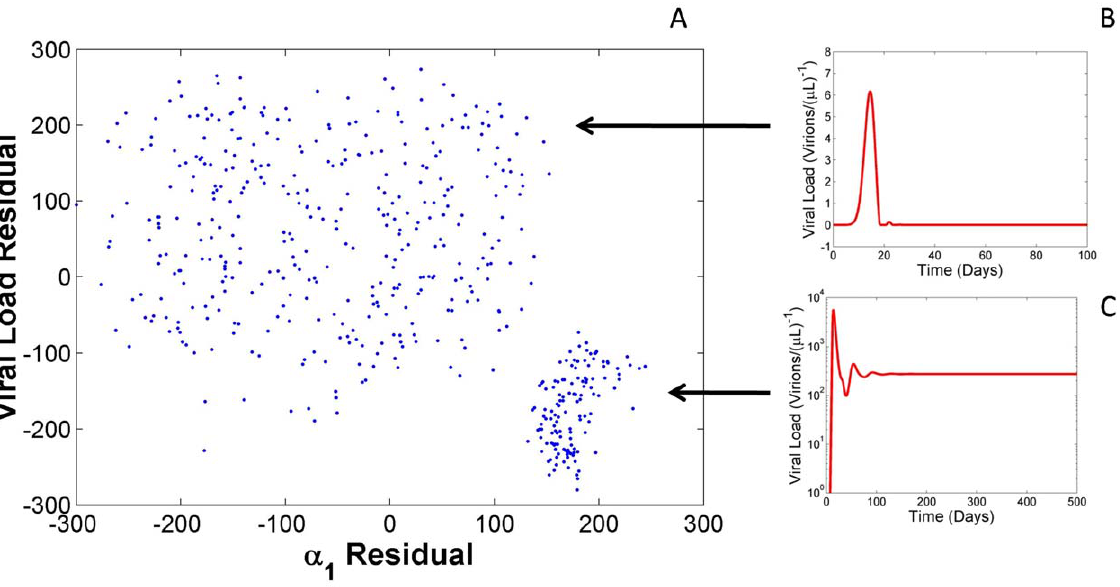
Figure 2. PRCC analysis of the a 1 parameter reveals strong bifurcation. (A) A plot of the weighted PRCC residuals of a 1 against viral load reveals two clusters. (B) Representative plot of cluster 1 viral dynamics. Parameter sets within cluster 1 were simulated and complete viral load clearance was seen within the first two weeks of infection for all points found within the cluster, thus signifying a largely non-biological dynamic. (C) Representative plot of cluster 2 viral dynamics. Parameter sets within cluster 2 revealed high steady state viral loads representative of the patient fits. Viral steady state was measured at t = 200 days over a range of a 1 values from 0.0 to 1.0 (day) 1 .